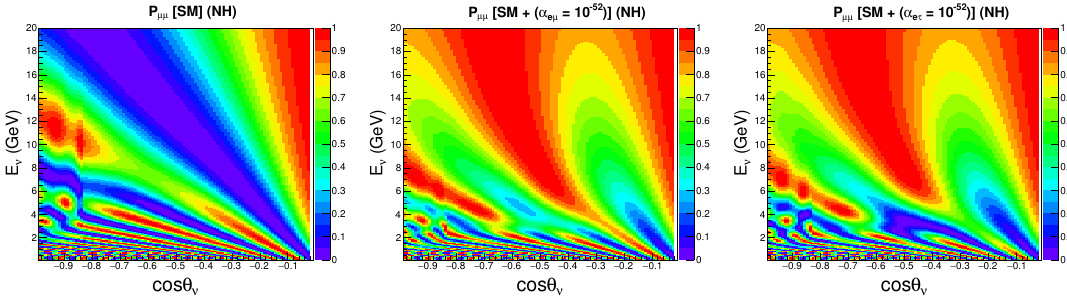
Figure 6 . The oscillograms for (cid:23) (cid:22) ! (cid:23) (cid:22) channel in E (cid:23) , cos (cid:18) (cid:23) plane for three di(cid:11)erent scenarios: i) (cid:11) e(cid:22) = (cid:11) e(cid:28) = 0 (the SM case, left panel), ii) (cid:11) e(cid:22) = 10 (cid:0) 52 , (cid:11) e(cid:28) = 0 (middle panel), and iii) (cid:11) e(cid:22) = 0, (cid:11) e(cid:28) = 10 (cid:0) 52 (right panel). Here, in all the panels, we assume NH.